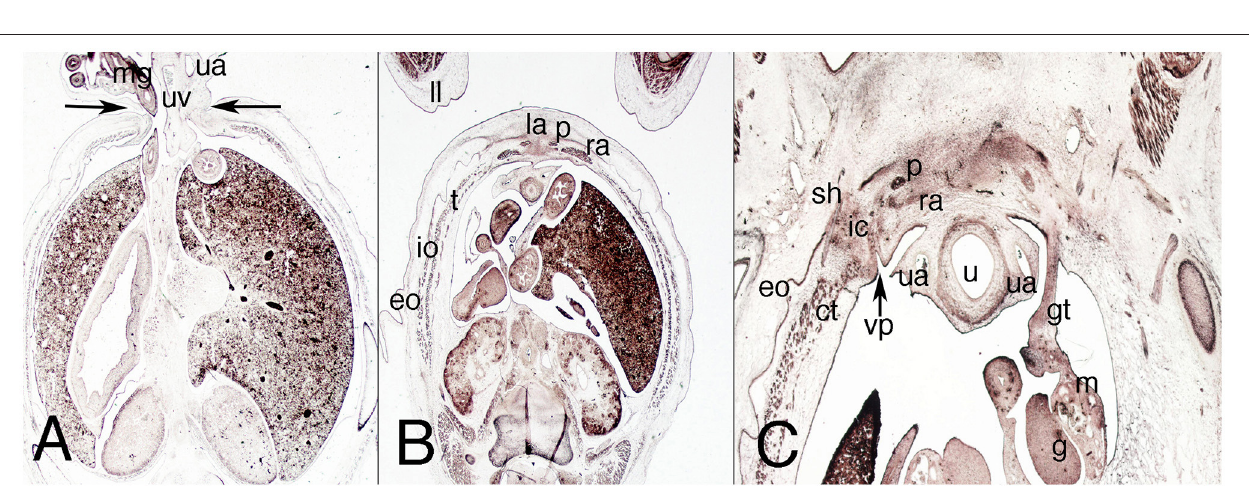
FIGURE 7 | Cross sections of the abdominal cavity of the embryo MARC-1 (stage 21). Hematoxylin and eosin staining. (A) (2X) at the level of the infra-umbilical region, upper third; (B) (2X) at the lower third, inguinal canal. a, allantoid; eo,external oblique, g, gonad; gt, gubernaculum testis; ic, inguinal canal; io, internal oblique; la, linea alba; m, mesonephros; ra, rectus abdominis; t, transversus abdominis; ua, umbilical artery.